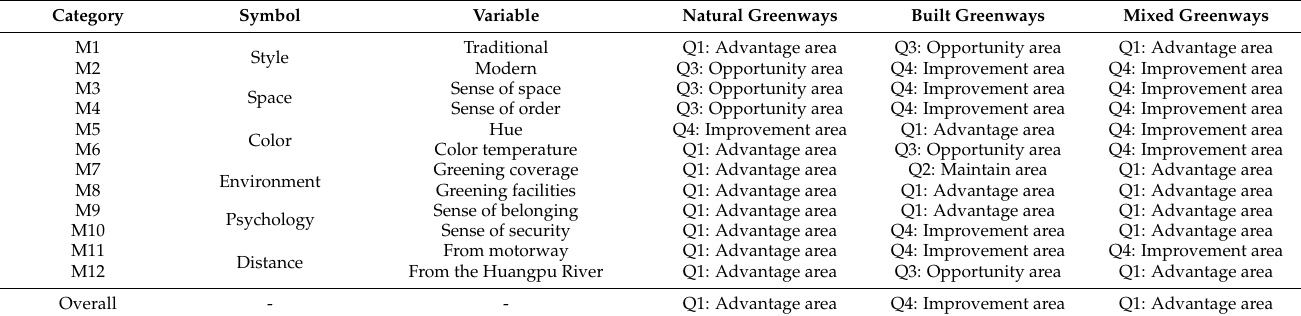
Table 7. Importance–performance analysis quadrant placement of three types of urban